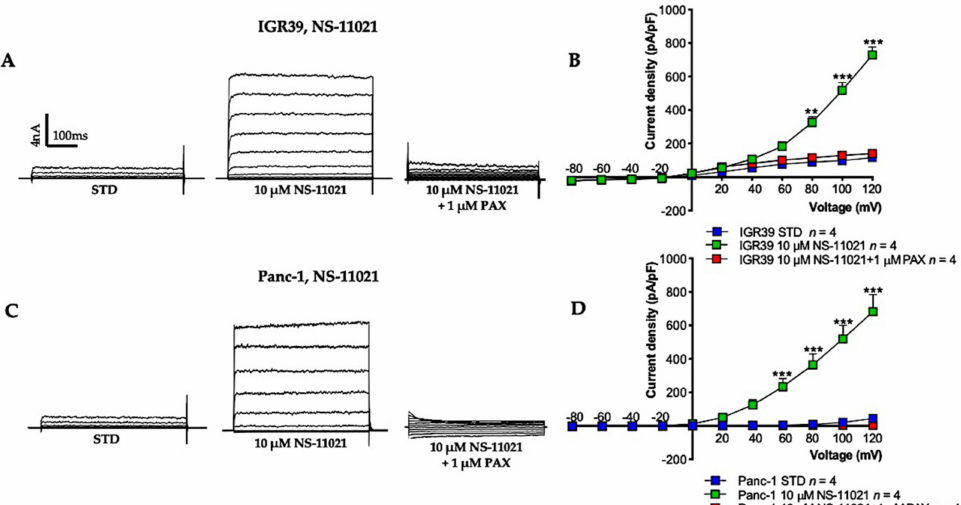
Figure 2. Effect of NS-11021 on membrane current in IGR39 and Panc-1 cells. Representative current traces obtained before and after NS-11021 addition, and after additional application of 1 µ M paxilline in cells stimulated with voltage increments of +20 mV from − 80 to +120 mV applied from a holding potential of -50 mV in ( A ) IGR39 and in ( C ) Panc-1. The duration of the voltage steps was 500 ms. Current density-voltage relationship measured in whole-cell patch-clamp experiments ( B ) in IGR39 and ( D ) in Panc-1. ** p < 0.01 and *** p < 0.001 versus STD condition, as determined by paired Student’s t -test. (n) refers to the number of cells.